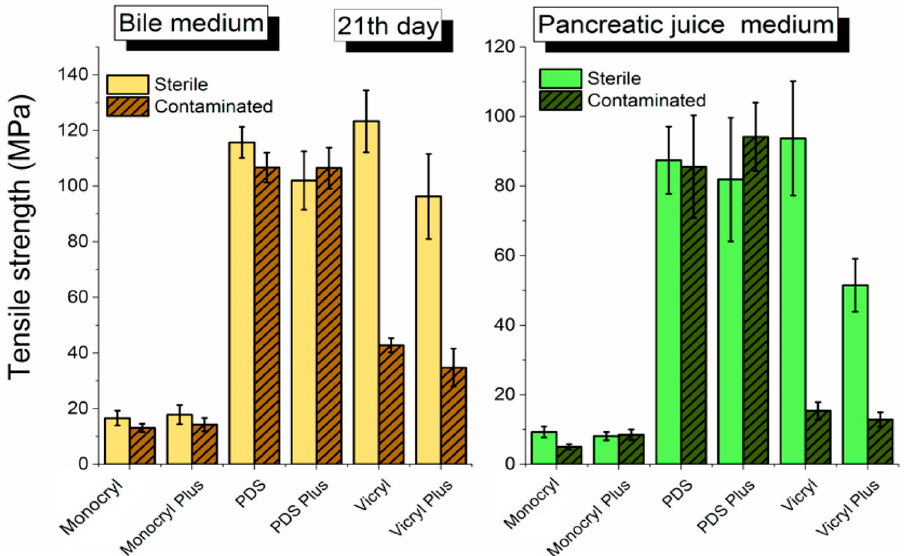
Figure 4. Comparison of the tensile strength of surgical sutures in bile and pancreatic juice (sterile and contaminated material) on day 21 of the